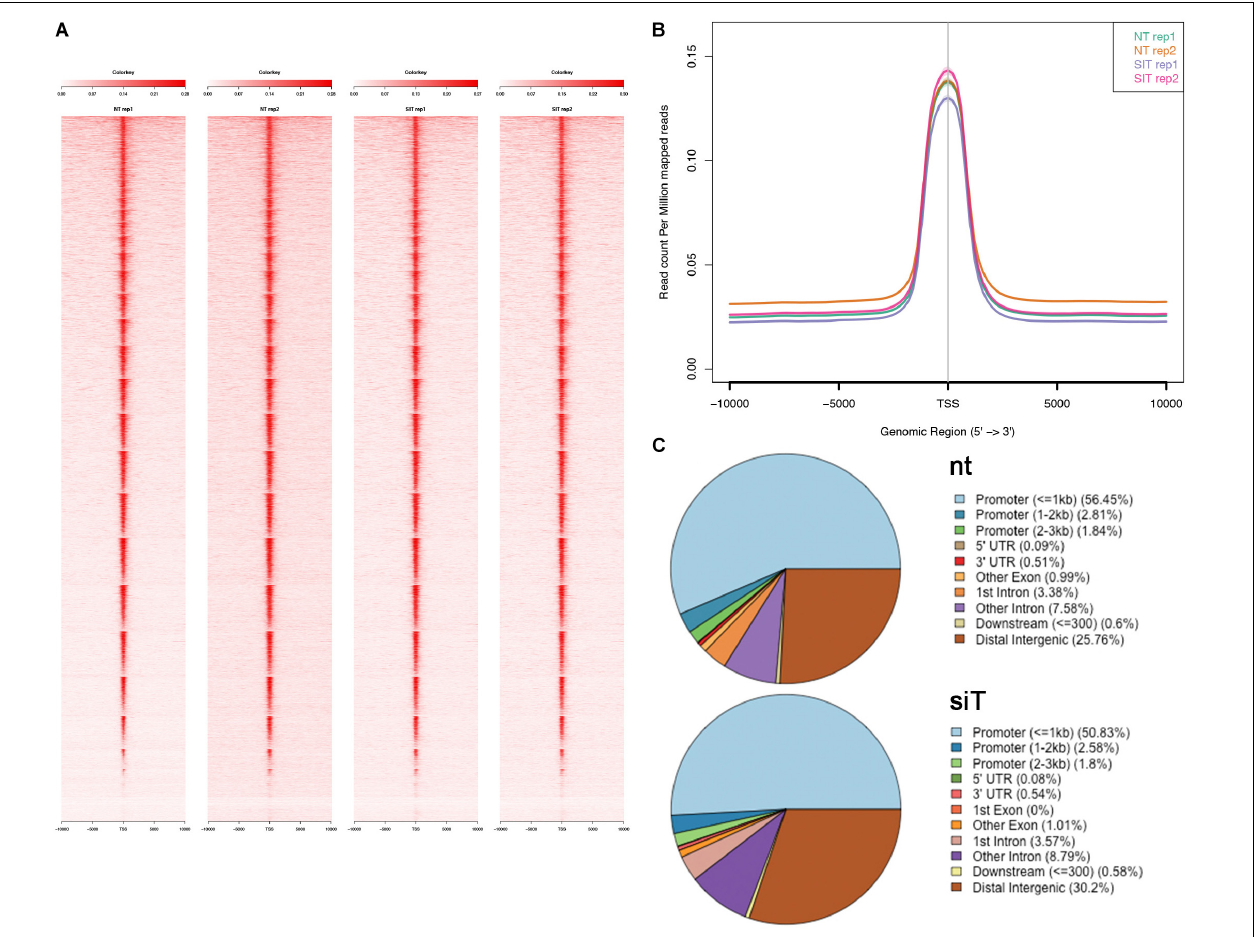
FIGURE 2 | ATAC-seq data using P19Cl6 cells differentiated at Day 1. (A) Heat maps of signal distribution around the transcription start site (TSS) ± 10000 bp of 14476 expressed genes in two control (NT, non-targeted siRNA) and two Tbx1 KD (SIT) replicates. (B) Average profiles of enrichment at the TSS in control and Tbx1 KD cells. Note the similar distribution of all four samples. (C) Pie charts illustrate the distribution of ATAC-seq consensus peaks relative to gene features. The distributions are very similar in controls (nt, number of consensus peaks = 23759) and Tbx1 KD cells (siT, number of consensus peaks =